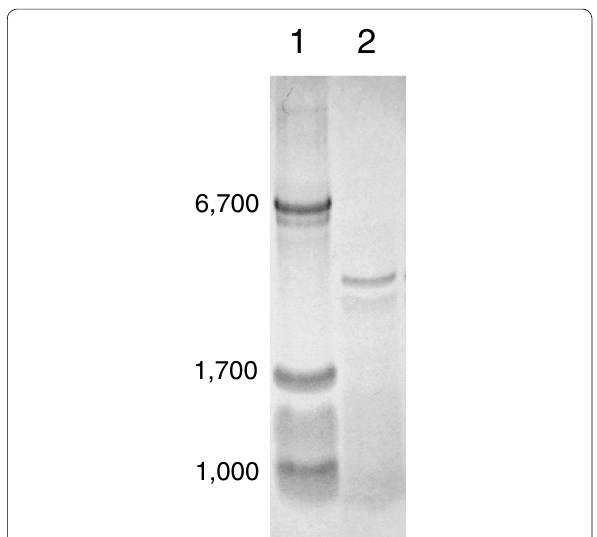
Fig. 1 Tirs/Tricine‑SDS‑PAGE analysis of the Natto peptide prepara‑ tion. The sample was applied on a 15–20% gradient polyacrylamide gel. Lane 1 molecular weight standards. Lane 2 Natto peptide prepara‑ tion at 10